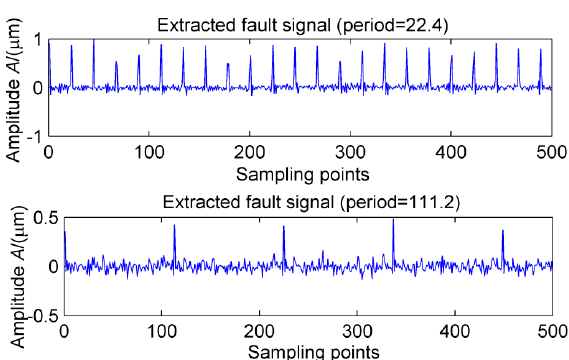
Figure 24. MOMEDA noise reduction for CPF 1 and CPF 2 .